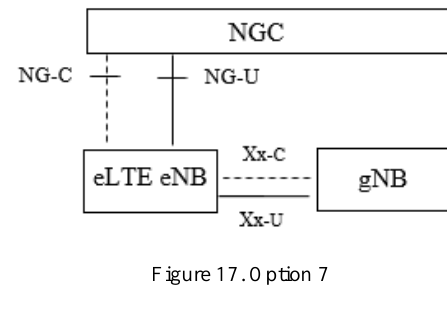
Figure 17. Option 7